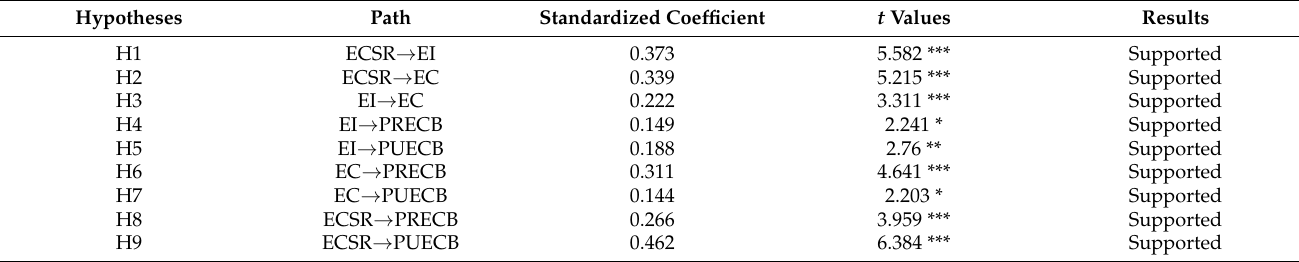
Table 4. Structural model analysis and hypothesis test